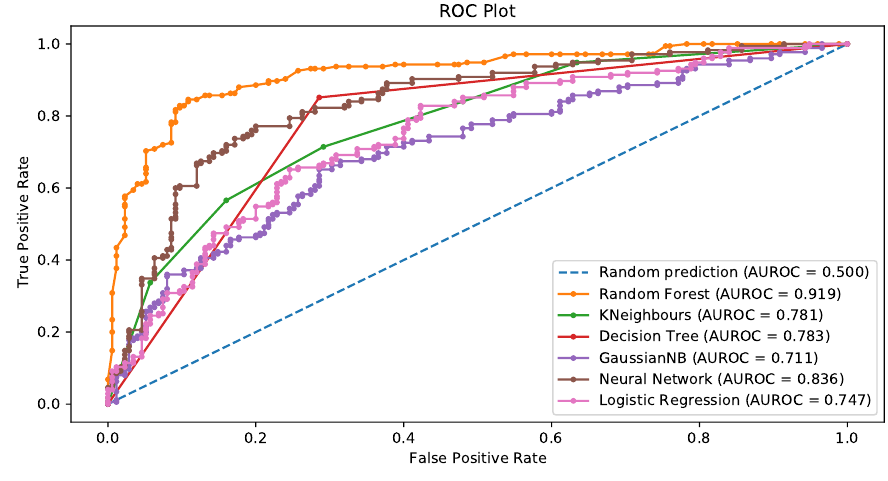
Figure 5. Random oversampling.